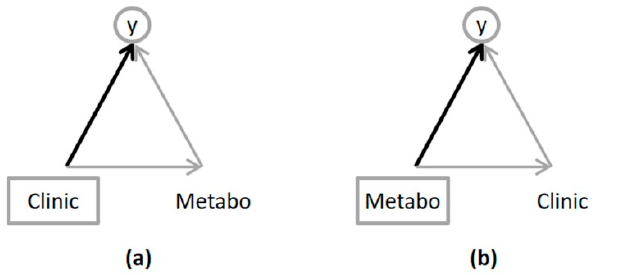
Figure 1. Path diagrams: ( a ) path 1; ( b ) path 2. The output variable is circled, and the input block is in a rectangle.